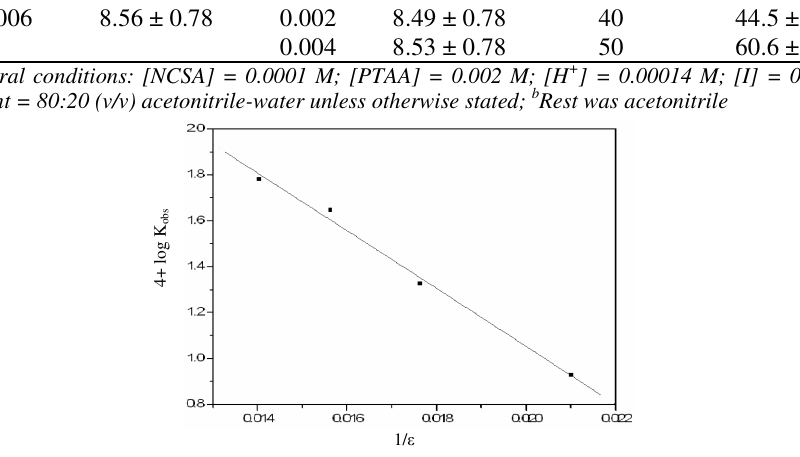
Figure 3. Plot of log k versus 1/ ε for the oxidation of PTAA with NBP obs